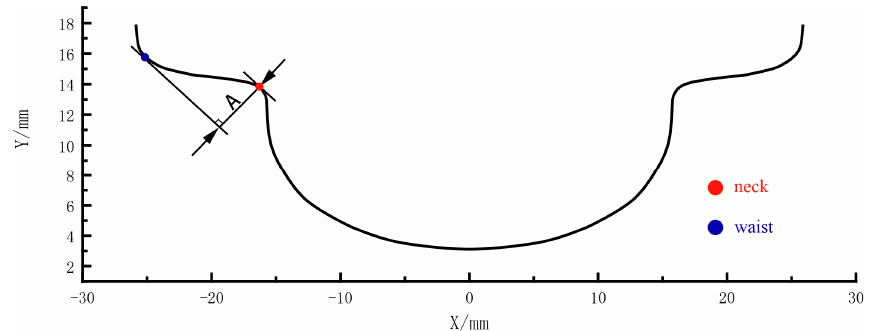
Figure 7. Schematic diagram of amplitude measurement.